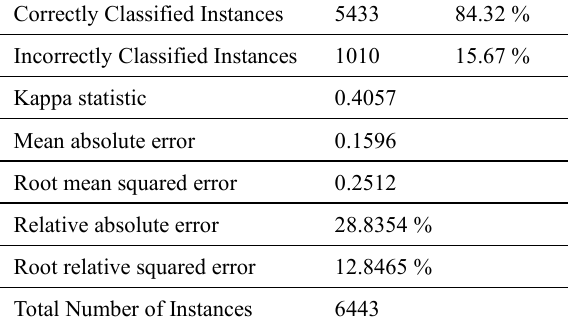
Table 2. Classification overview